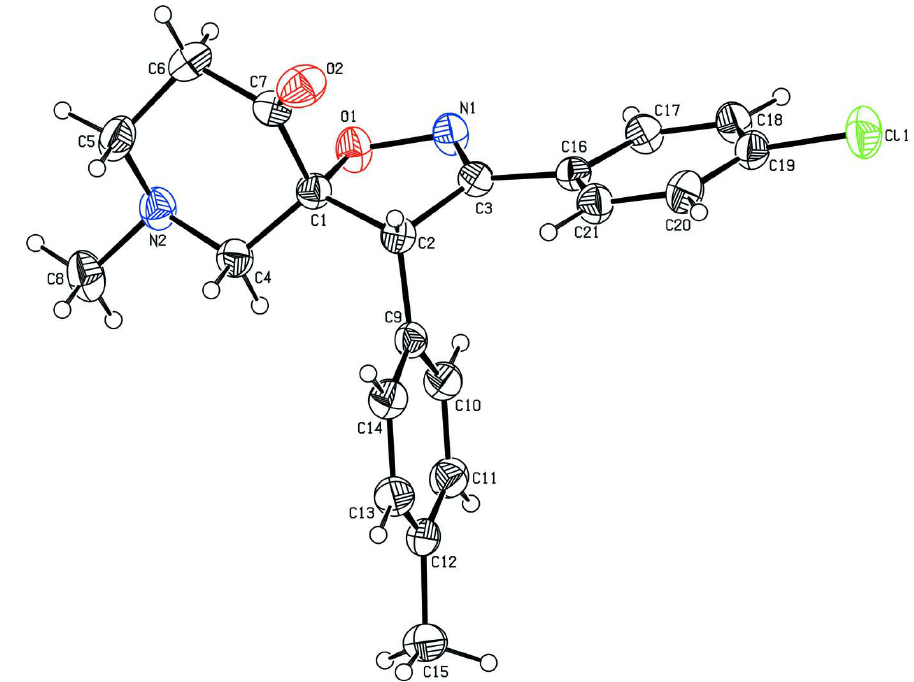
Figure 1 The molecular structure of the title compound, showing 30% probability displacement